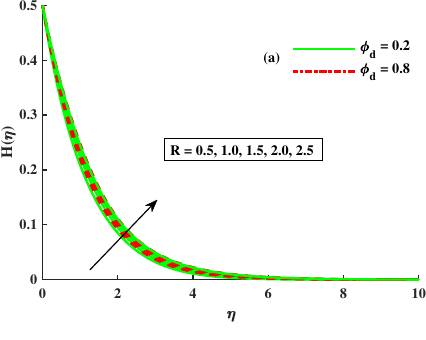
Figure 7. Fluctuation of R , Λ and φ d on H ( η ) .